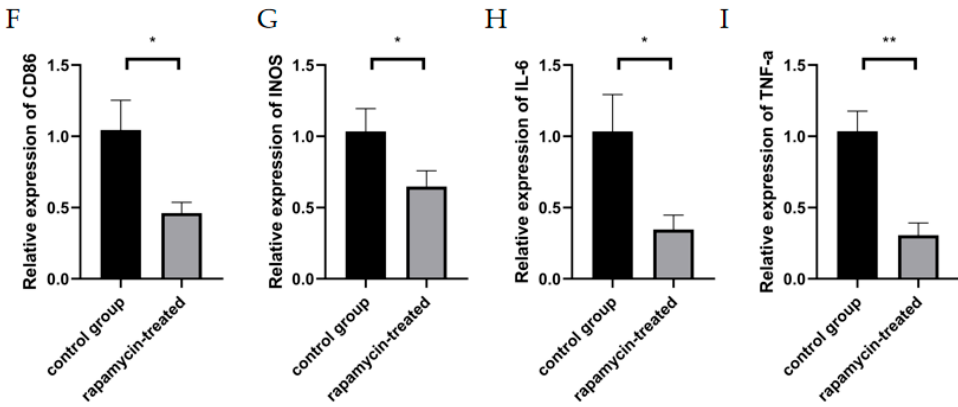
Figure 5. The effect of RAPA treatment on CNV. ( A ) Representative images of alkali-burned mice treated with RAPA on day 7 and day 14. ( B ) Quantification of CNV area in the rapamycin-treated group and the control group on day 7 and day 14. n = 6:6. ( C ) The changes in Beclin1 and ATG5 protein expression in the corneas of untreated alkali burned mice and those of rapamycin-treated alkali burned mice analyzed by Western blot. ( D , E ) Quantification of the Western blot result for Beclin1 and ATG5 in ( C ). n = 3:3. ( F – I ) mRNA expression of M1 macrophage markers (INOS, CD86, IL-6, TNF- α ) analyzed by RT-qPCR in mouse corneas. n = 3:3. Unpaired t -test was used to analyze